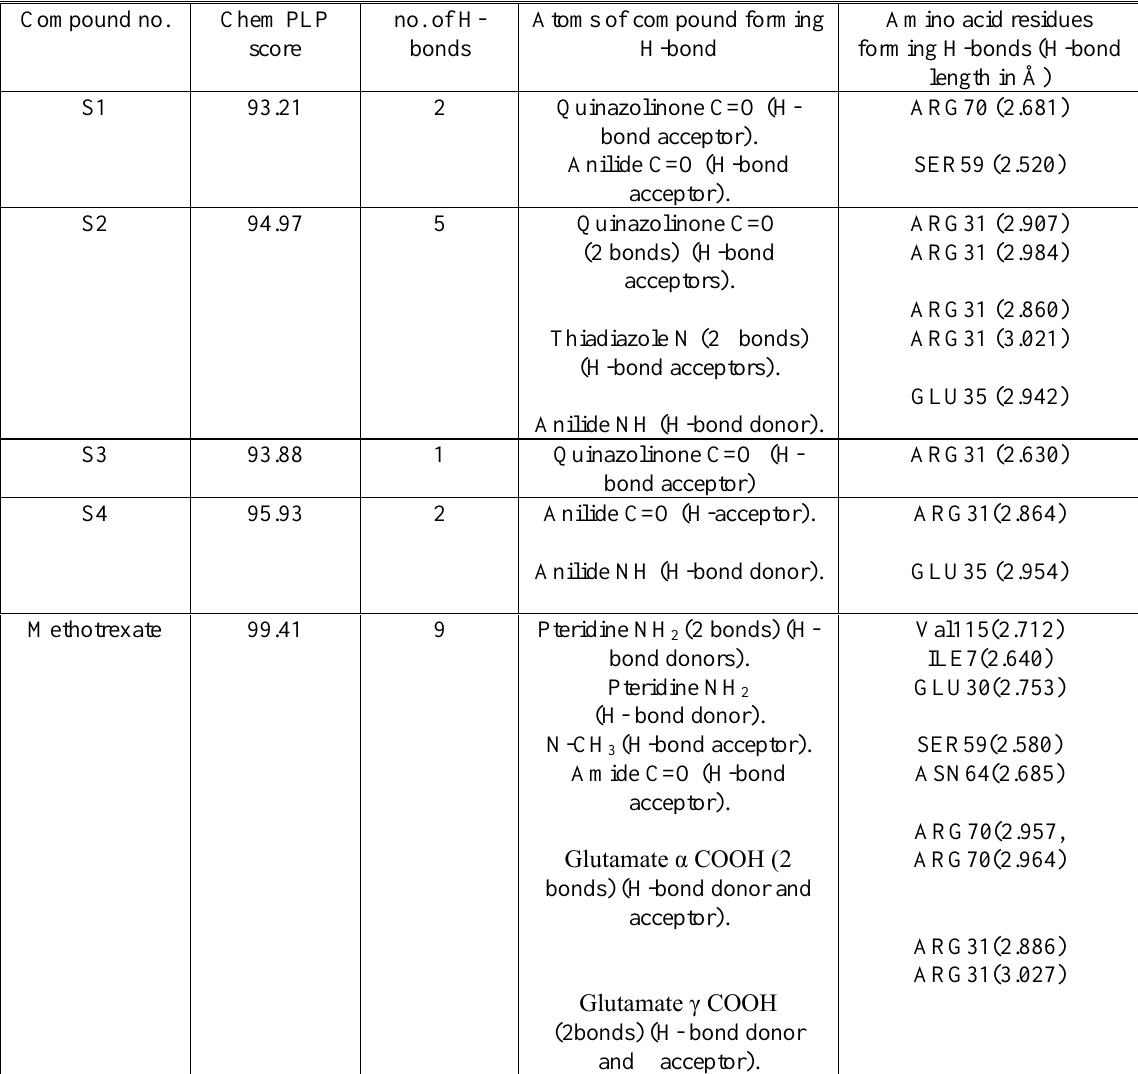
Table 2. Docking study data showing amino acid interactions and the hydrogren bond lengths of target compounds and methotrexate on DHFR (PDB: 3EIG). Compound